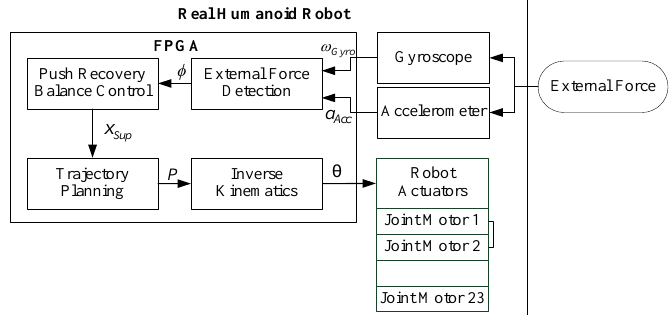
Figure 4. Description of the input/output of the executing process from sensors to actuators and the four modules of the proposed balance control method implemented on the field-programmable gate array (FPGA) chip.